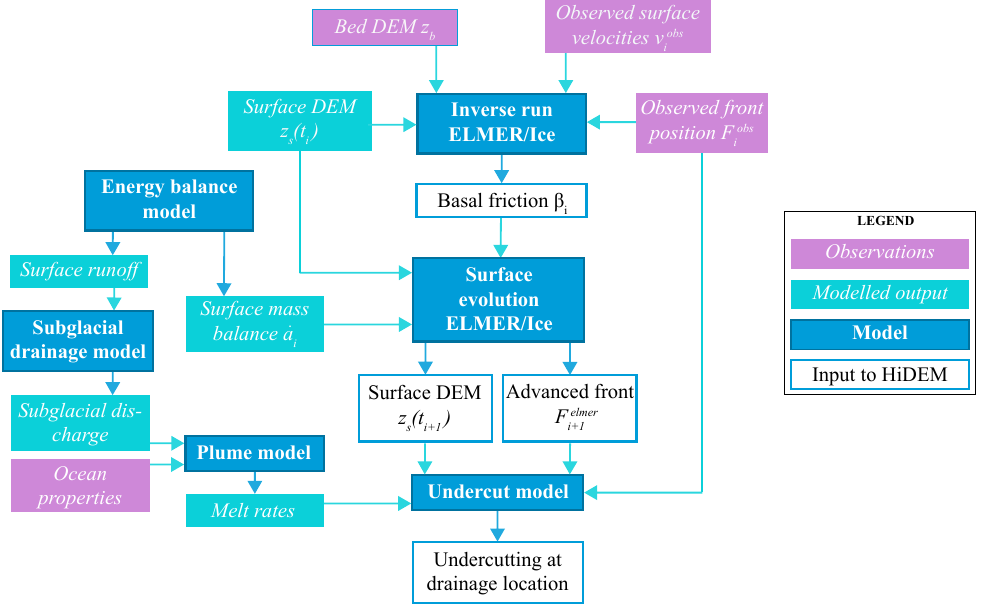
Figure 2. Model scheme presenting the calculation of the sliding and geometry (Elmer/Ice) as well as the undercutting at the subglacial discharge as input to the glacier calving from the HiDEM.